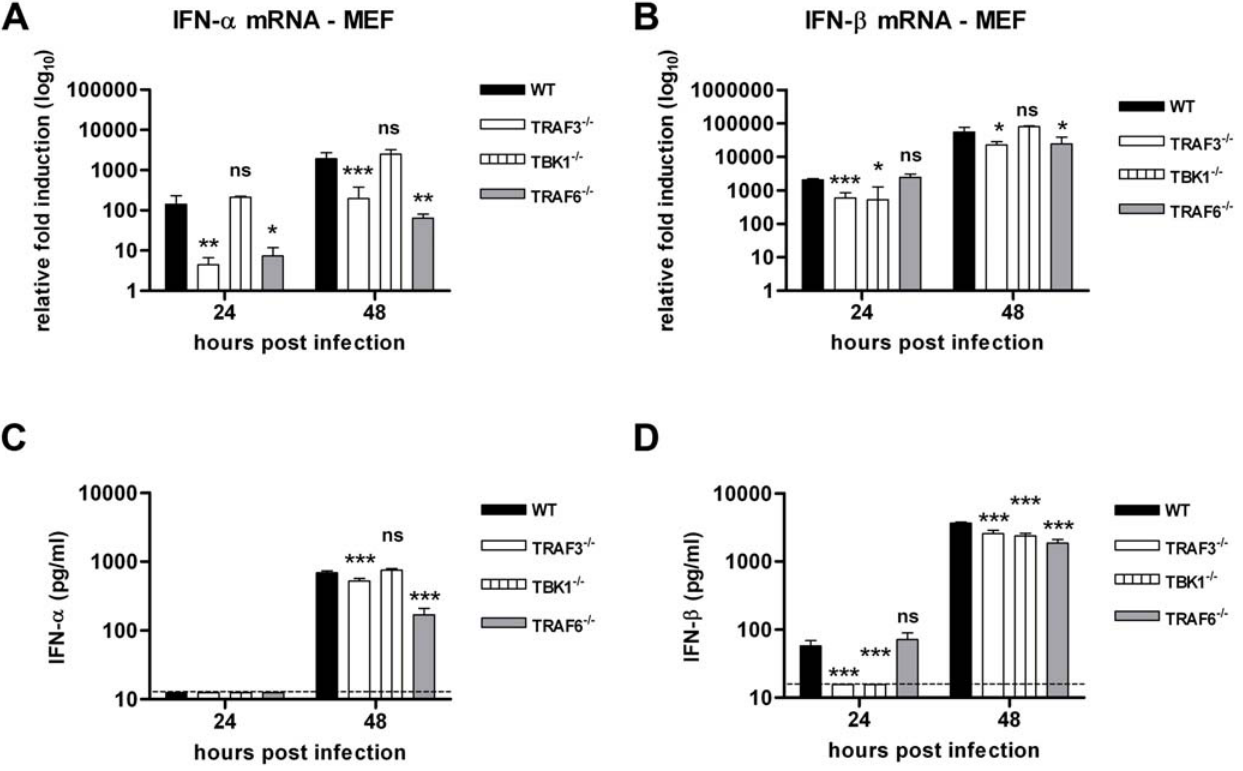
Figure 11. The early phase of the type I IFN regulation in MEF partially involves TRAF3 and TBK1 whereas the late phase requires TRAF6. TRAF3 2 / 2 , TBK1 2 / 2 and TRAF6 2 / 2 MEF were infected at an MOI of 0.1 and levels of ( A and C ) IFN- a and ( B and D ) IFN- b mRNA and secreted protein were measured by qRT-PCR and ELISA. Since basal mRNA expression of the IFN- b gene in uninfected TBK1 2 / 2 and TRAF6 2 / 2 MEF was lower than that observed in congenic wild type cells, for these cells only, we compared IFN- b mRNA levels to the wild type MEF. Values are an average of duplicate samples generated from three independent experiments. Asterisks indicate values that are statistically significant (***, P , 0.0001, **, P , 0.005, *, P , 0.05); n.s. indicates differences that were not statistically significant.